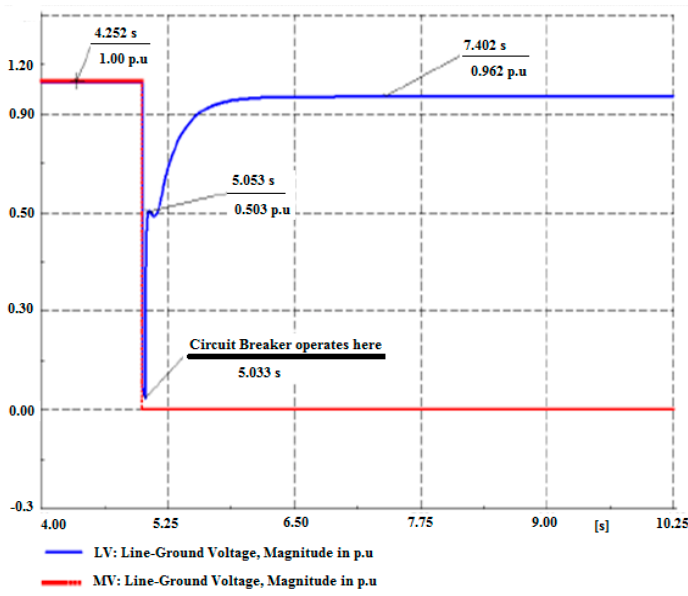
Figure 6. The voltage on bus R0 and bus R1 in case of grid connected and islanded mode.